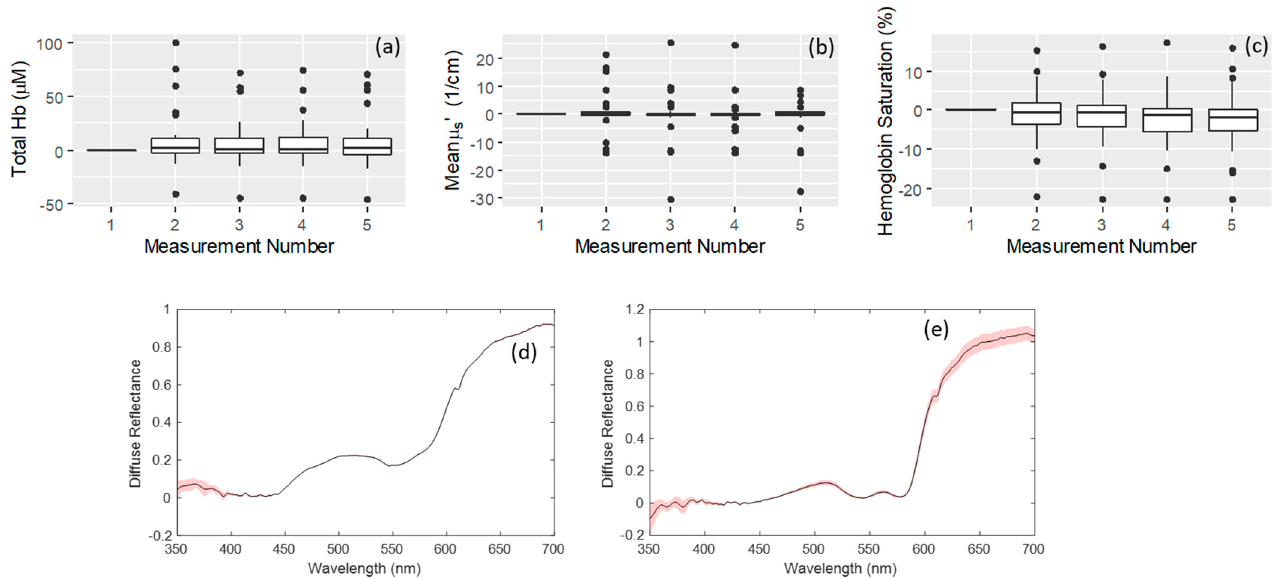
Figure 3. Plots showing consistency of repeated measurements. For each tissue sample, 5 repeated measurements were taken. The difference for each measurement with respect to the first measurement for that site are plotted here as box plots to indicate any trends in signal deviation. To simplify this plot, data are pooled across all measurement site types (cancer and non-cancer). For the case where there is no time dependent effect (due to probe pressure or other effect), the median value would be expected to remain at zero, indicating there is no change in signal over time. Using a linear mixed effects model indicated that there was no significant effect of the measurement repeat ( p > 0.1), indicating that the measurements are stable over time. Difference in total Hb ( a ), Mean μ s’ ( b ), and hemoglobin saturation ( c ) over five consecutive measurements are numbered 1 through 5 as indicated on the x-axis. The consistency with which individual spectra can be acquired is also illustrated in a representative example case, shown for the same tumor and normal tissue samples shown in Figure 2d,e. The mean and standard deviation of the tumor and normal spectra are plotted in ( d ) and ( e ), respectively, with the mean shown as a black line, and the standard deviation shown as a red outline (mainly visible at the upper and lower ends of the spectra).